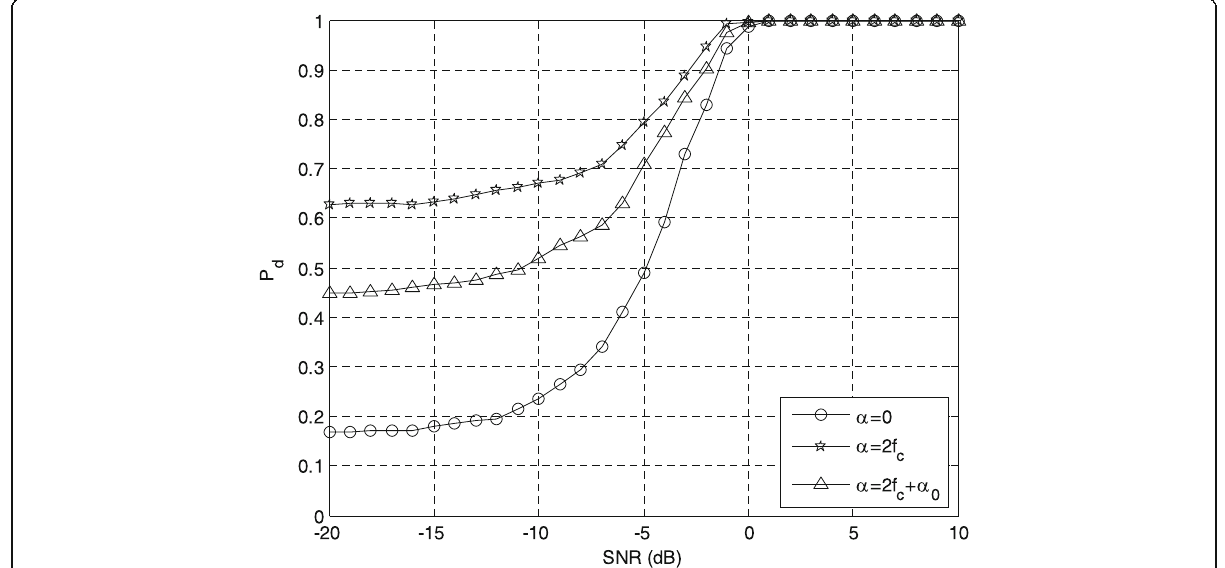
Fig. 3 Comparison of detection performance based on MRC method at different cyclic